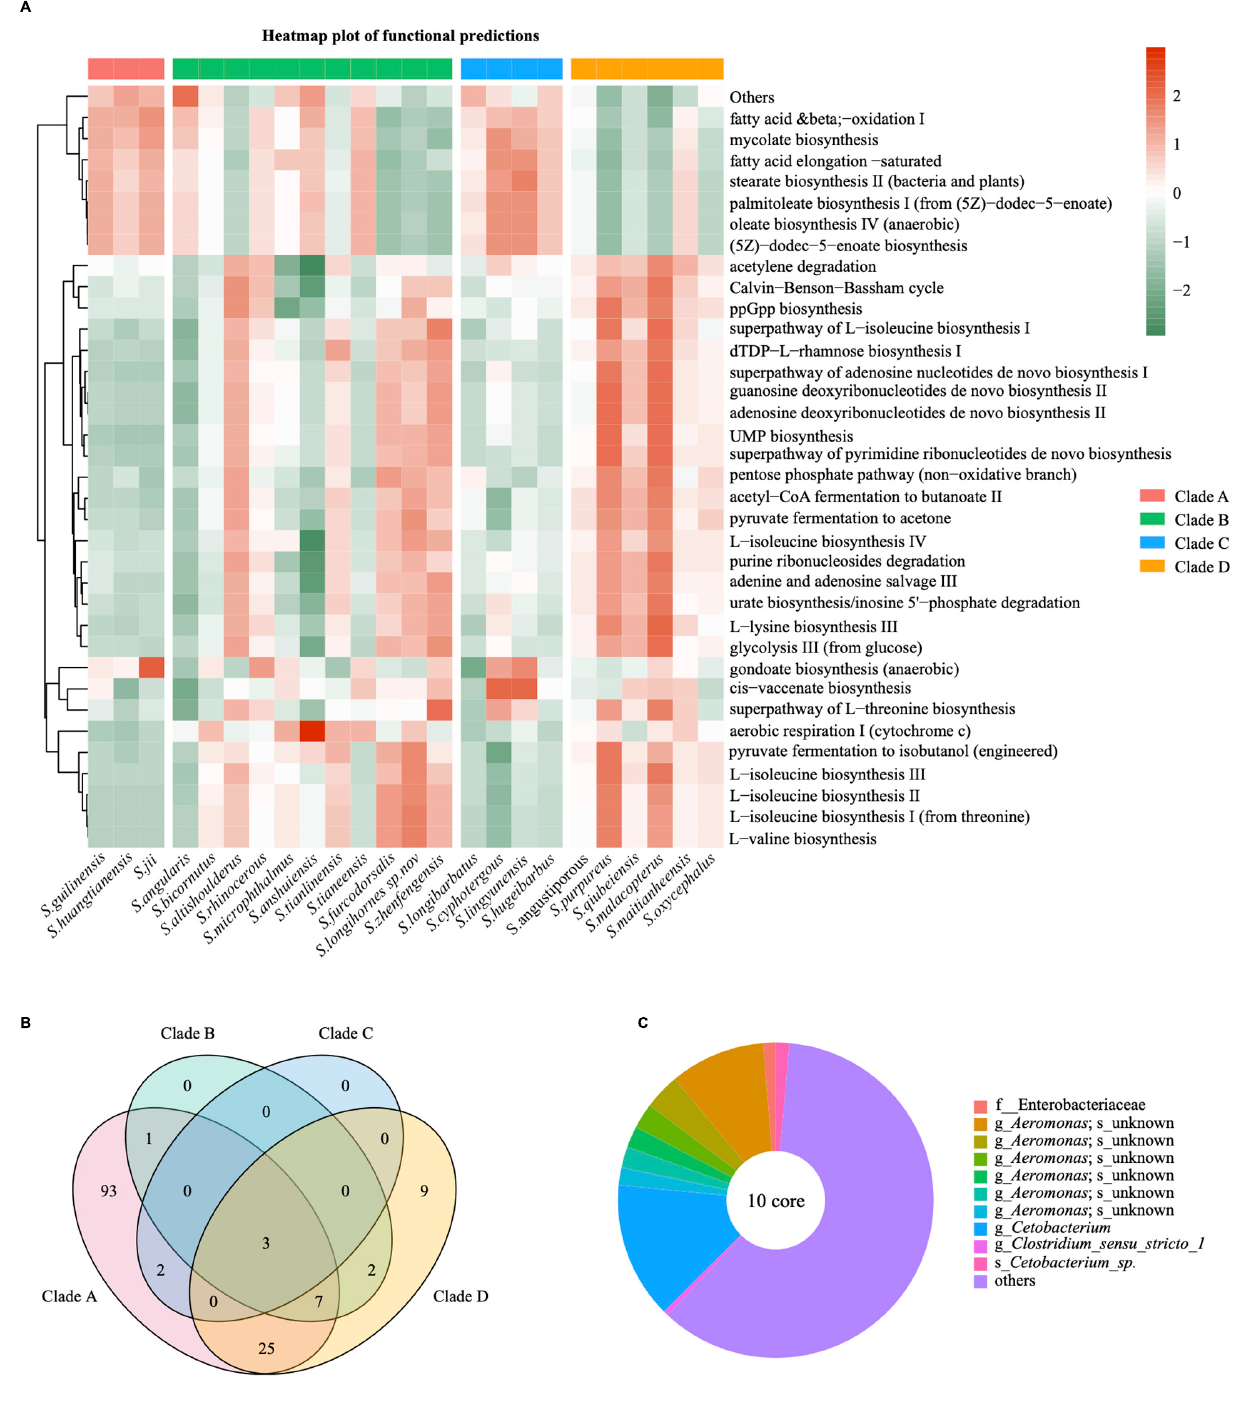
Frontiers in Microbiology |